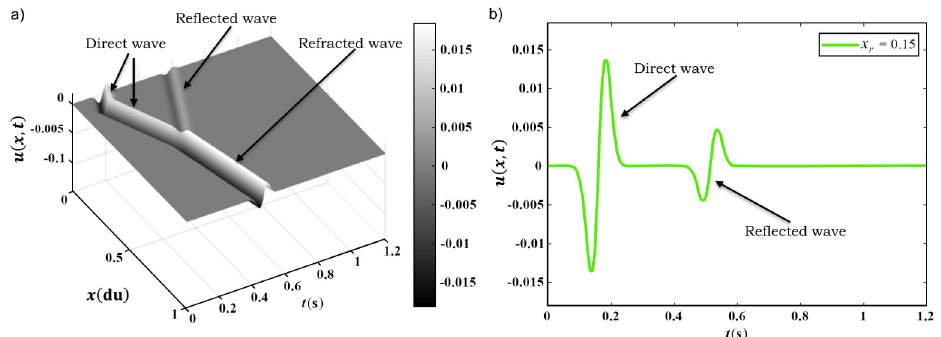
Fig 16. Wavefield propagation and observed data. (a) Evolution of wavefield propagation u ( x , t ) and (b) The observed data d obs or synthetic seismic trace recorded at x =